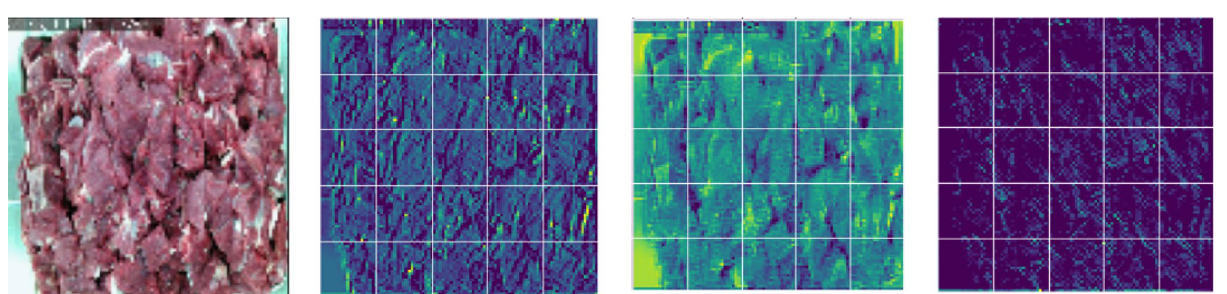
Figure 2. The DCNN image classification process. Source: Authors’ construction using Powerpoint.